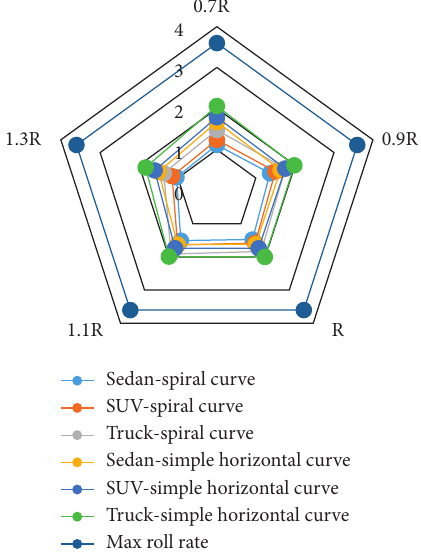
Figure 14: Maximum roll rates in the simple and horizontal curves for various radii and vehicle types at the speed of 100km/h.